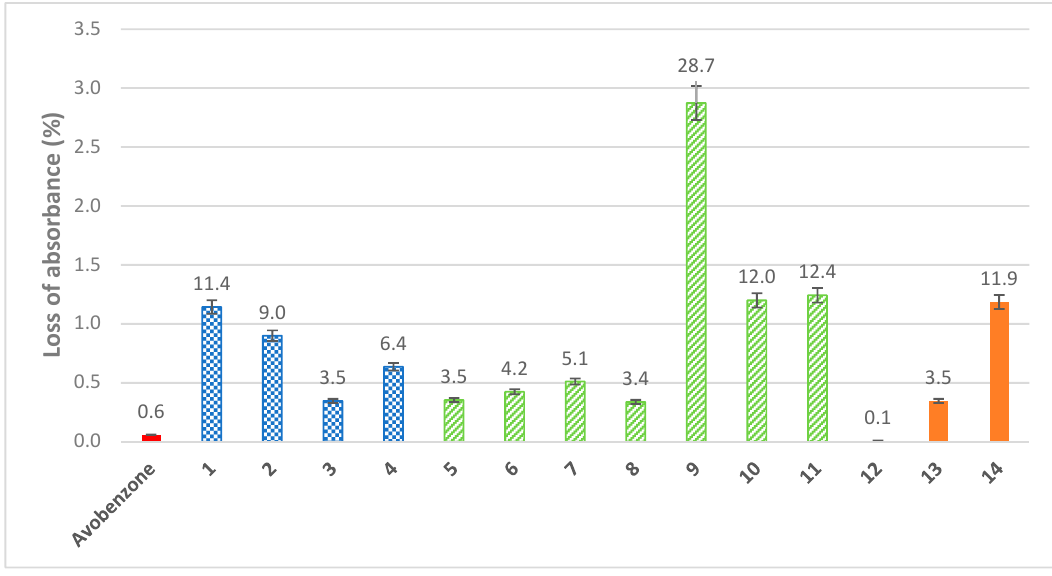
Figure 2. Loss of absorbance for phenolic series (blue checked pattern), furanic series (green stripe), and pyrrolic series (orange), after UV irradiation for 60 min, compared with avobenzone (concentration = 10 µmol.L − 1 in ethanol).